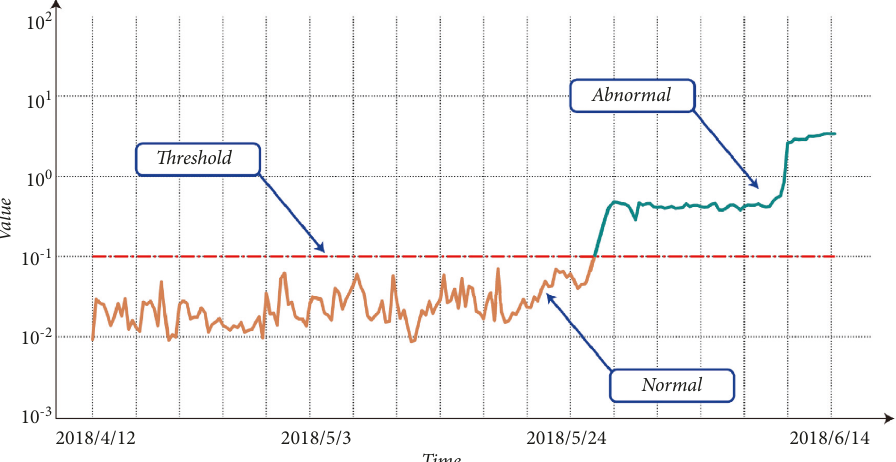
Figure 11: Detection of pump damage time of well 951352447 by